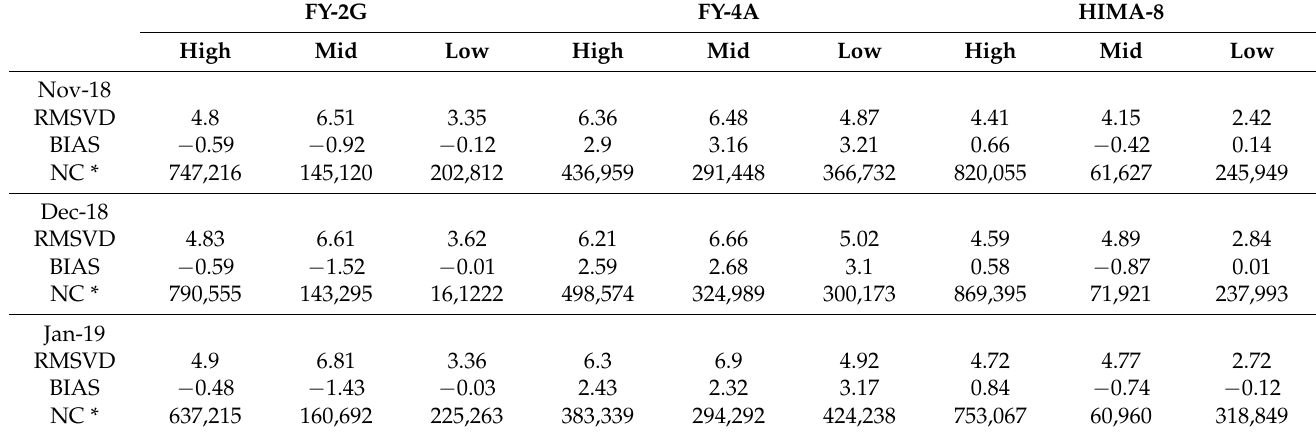
Table 2. Monthly comparison of homogeneous samples of FY-2G, FY-4A and HIMA-8 infrared AMVs with respect to NCEP FNL wind analysis for different atmospheric levels over the retrieval domain at QI 85% for the three months starting from 1 November 2018 to 31 January 2019.